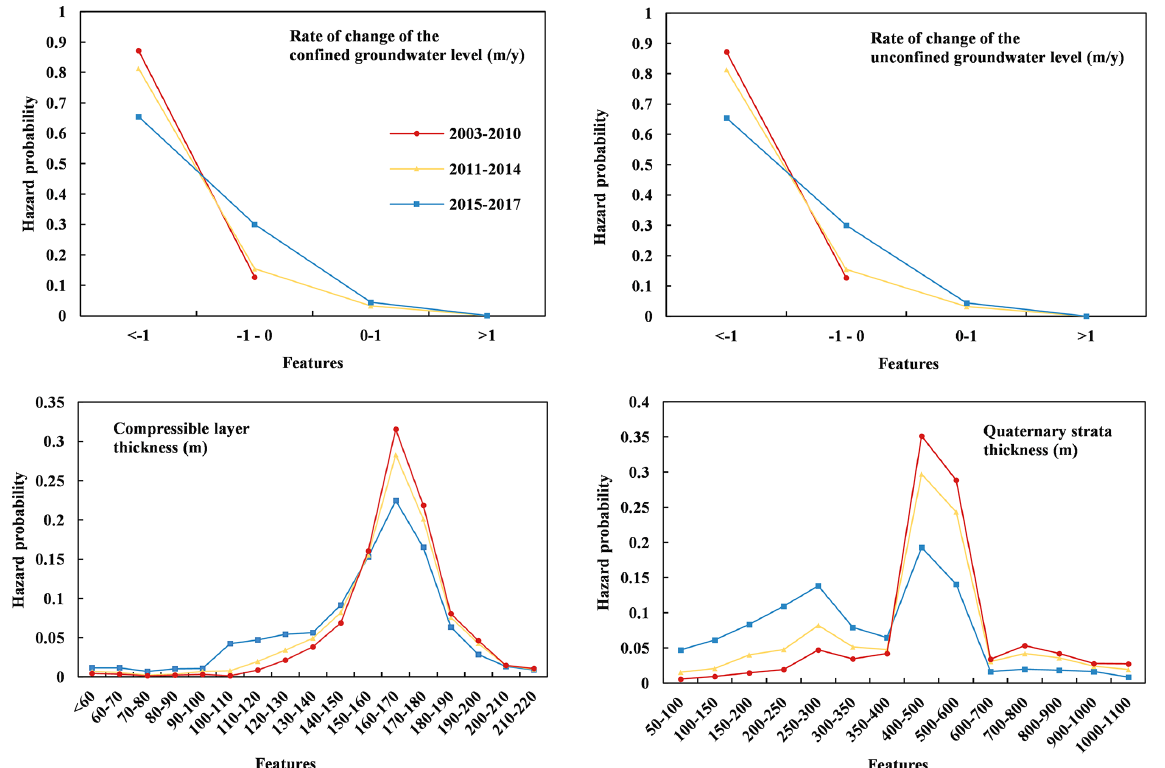
Figure 8. Hazard probability of the selected four factors for the three time periods considered in the